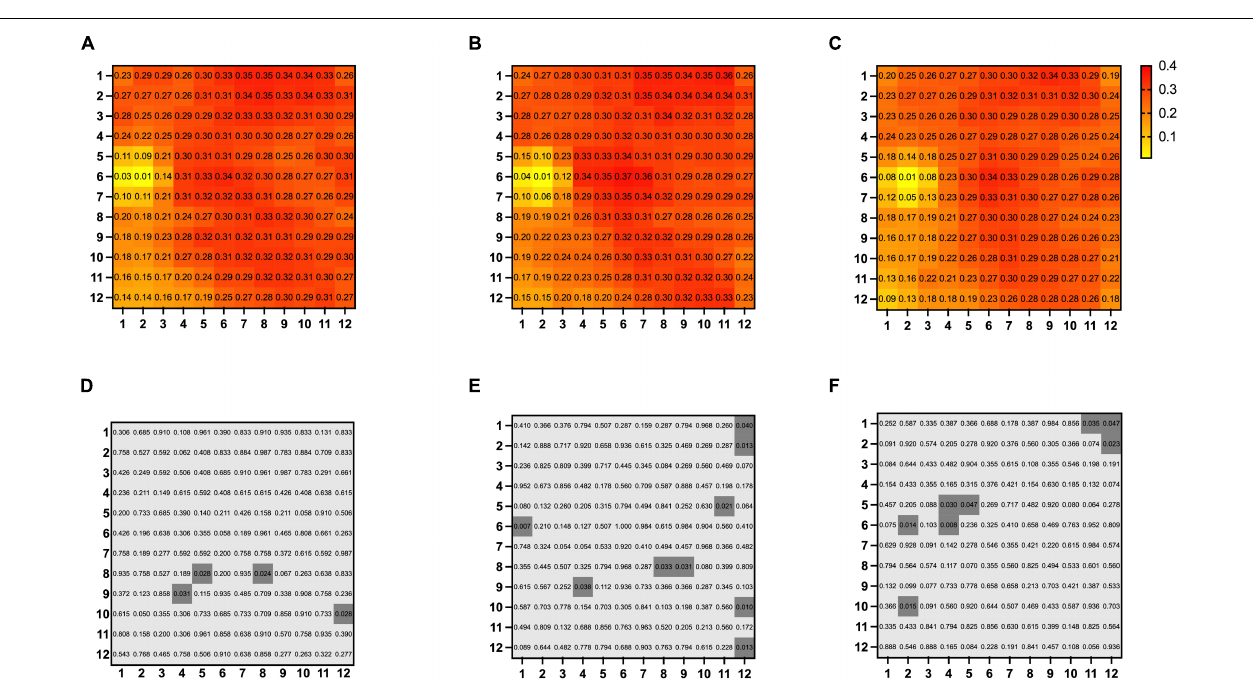
FIGURE 2 | Map of mean choroidal vascularity index 12 * 12 mm grids in BRVO eyes (A) , fellow eyes (B) , and control eyes (C) . Comparison of CVI in each of the 12 * 12 mm grids between BRVO eyes and fellow eyes (D) , BRVO eyes and control eyes (E) and fellow eyes and control eyes (F) . A p -value of less than 0.05 was highlighted with a darker gray background. Presented in left eye mode.